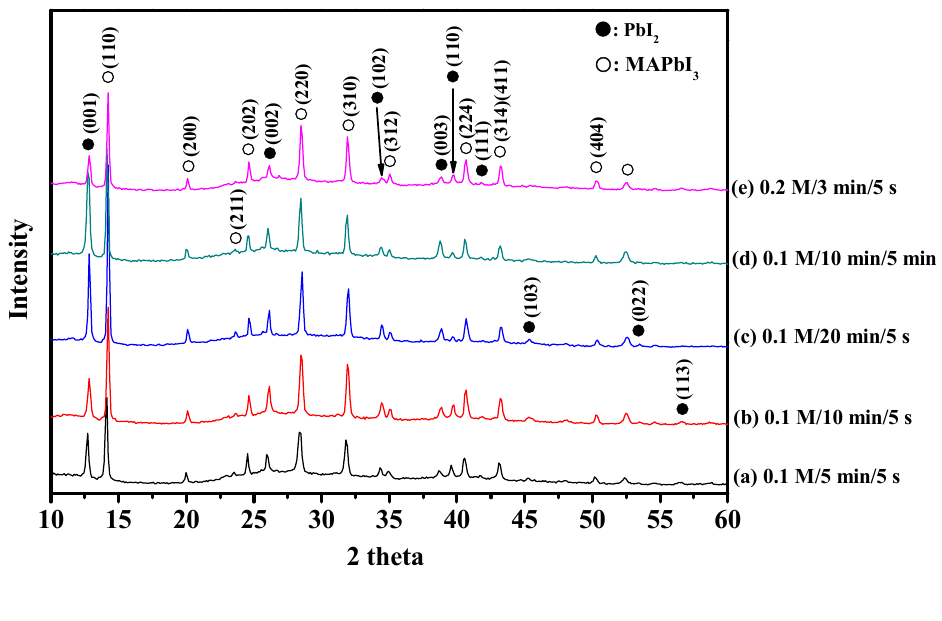
Figure 8. XRD images of MAPbI 3 /PVP composite fibers produced at different MAI/IPAconcertaion/immersing time/IPA rinsing time.